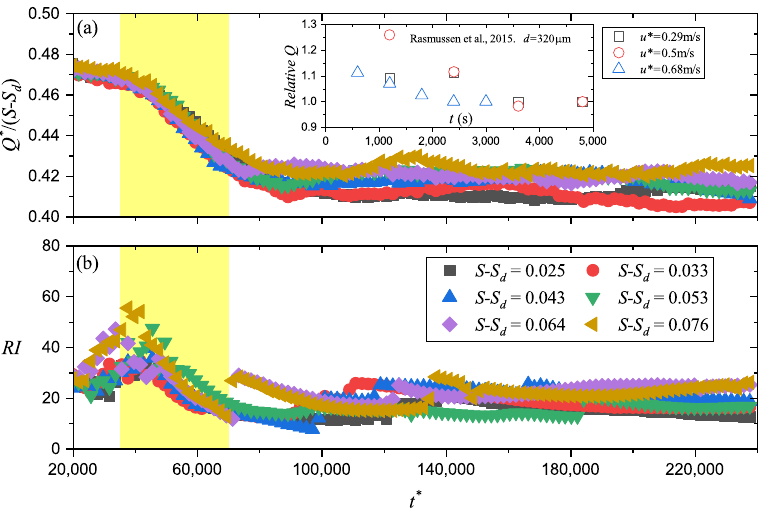
Figure 4. Sand flux ( a ) and ripple index ( b ) varies with time during the ripple formation and development process. Different colors represent different wind strengths. The bright yellow shades highlight the initial stage. The inset in ( a ) shows the flux decrease observed in the wind tunnel experiment [4]. The relative Q is the flux normalized by the last observed flux